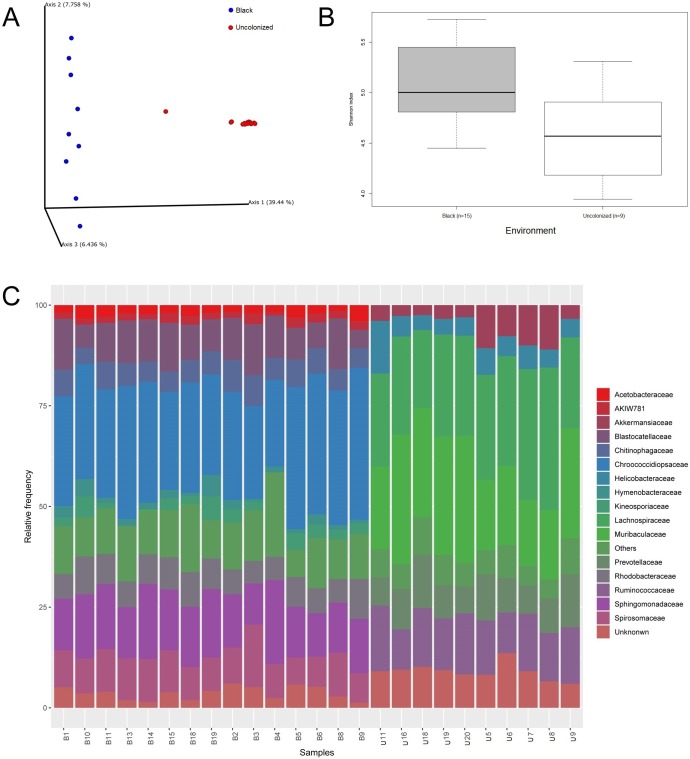
Statistical analyses of 16S rRNA gene sequencing data.(A) Beta diversity represented by Principle Coordinate Analysis Emperor plot on a Bray-Curtis distance matrix; (B) Boxplots of Alpha-diversity Index (calculated as Shannon index) in both black patina and uncolonized region samples; (C) Stacked bar charts of the taxonomic profile at family level, low abundance taxa are lumped together in the “Others” category.